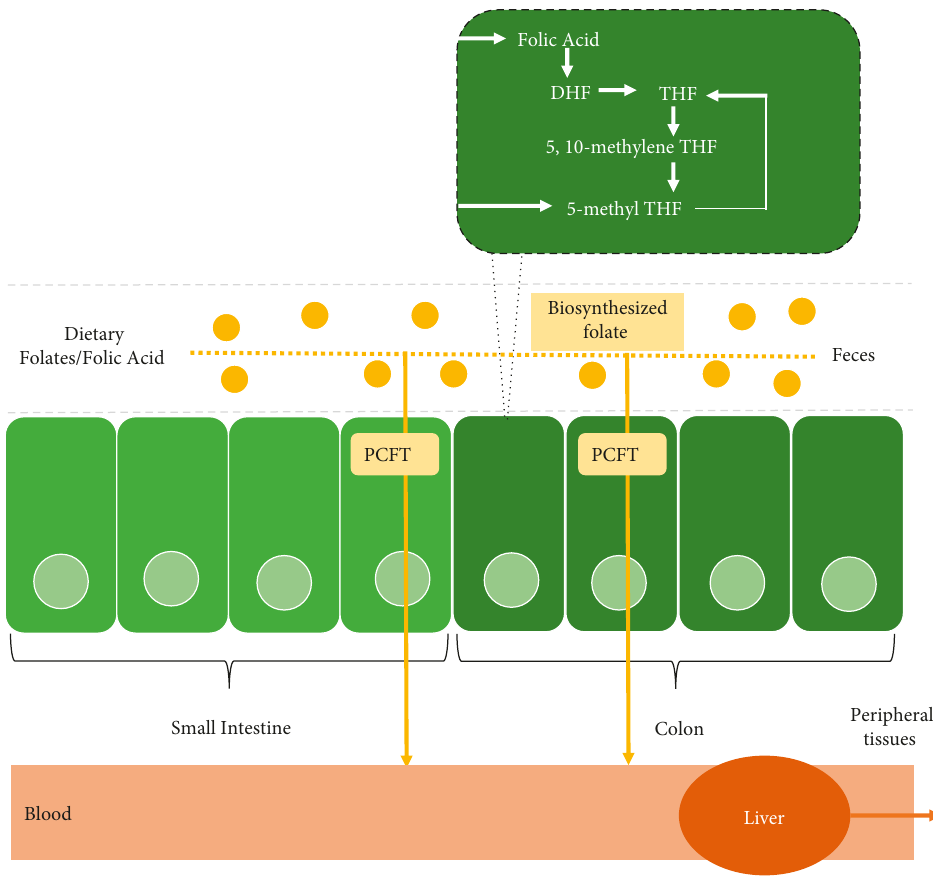
Figure 2: Folic acid absorption and